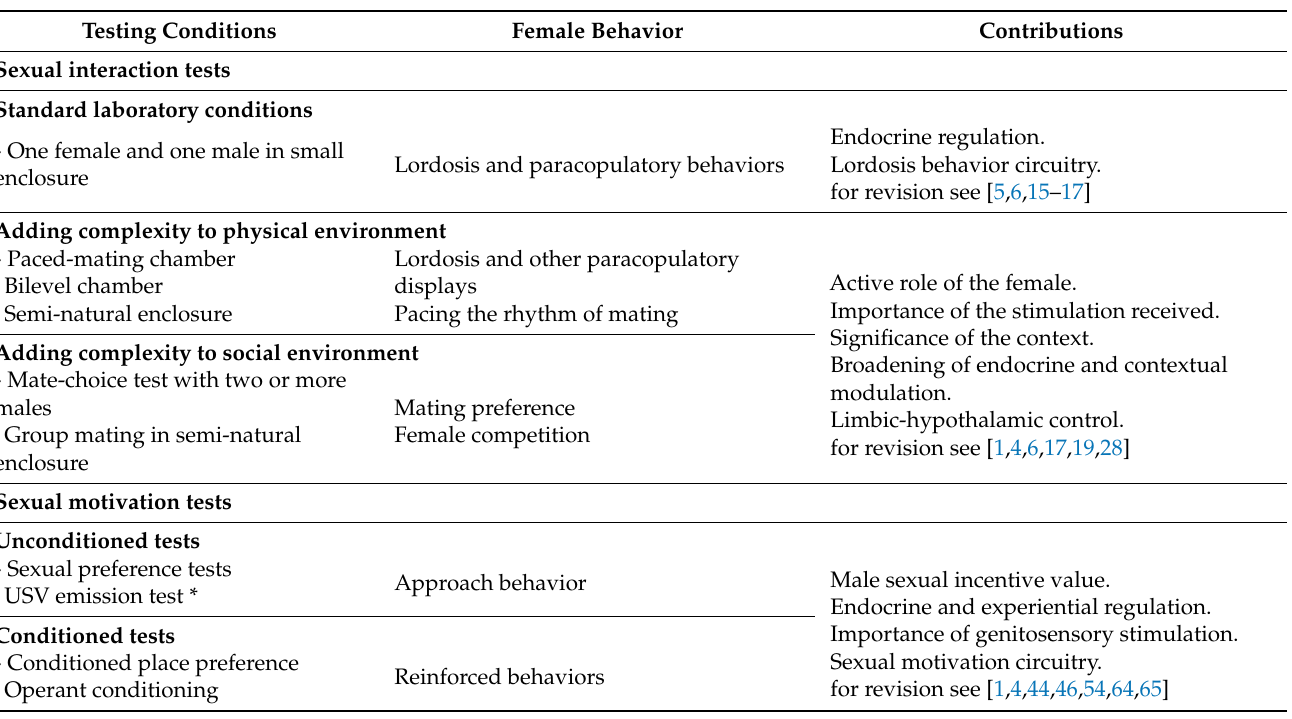
Table 1. Behavior of sexually active female rats under different testing conditions and its contribution to the understanding of sexual